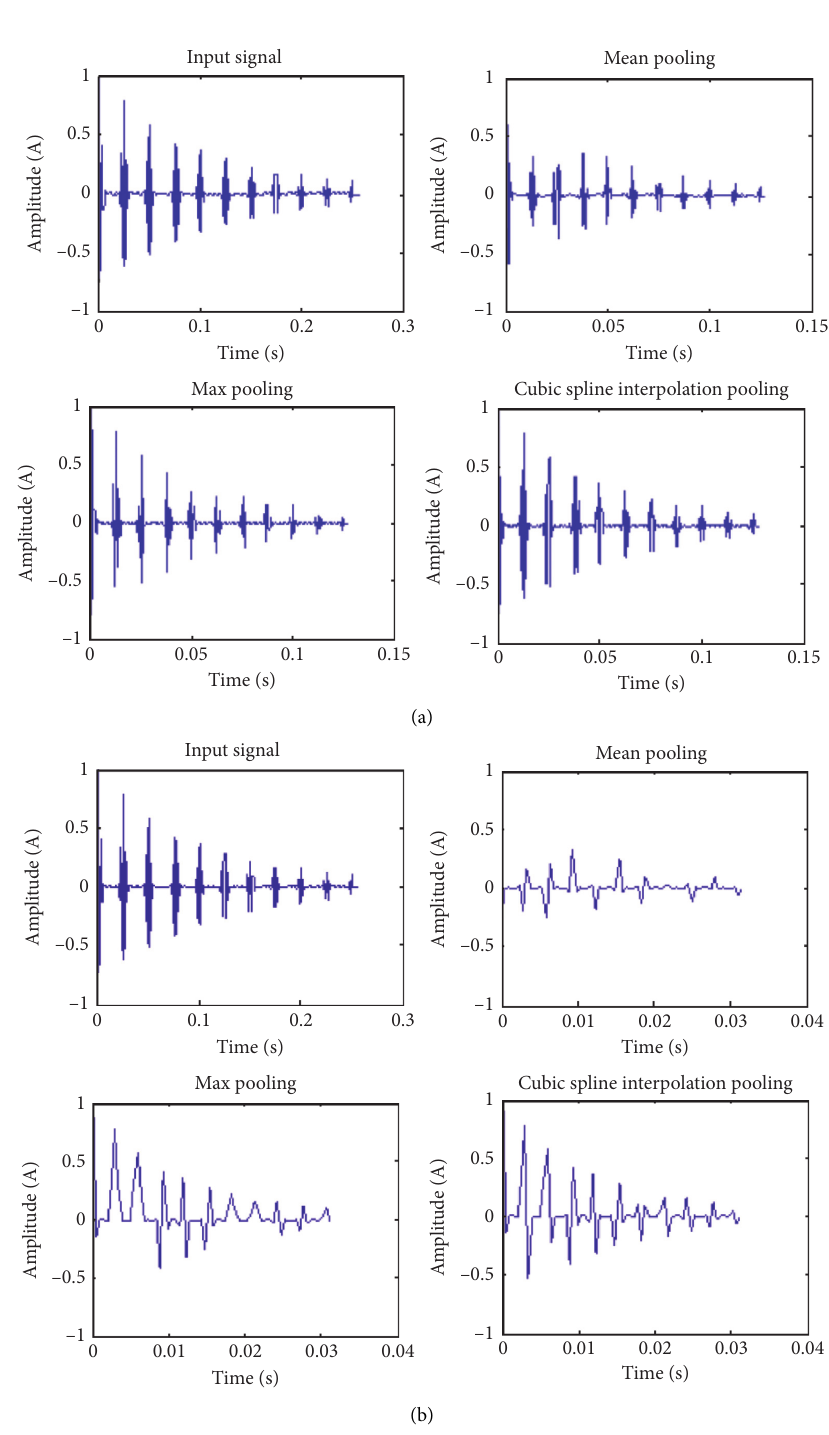
Figure 8: Time-domain waveform of the periodic pulse signals when the step size is (a) 2 and (b)